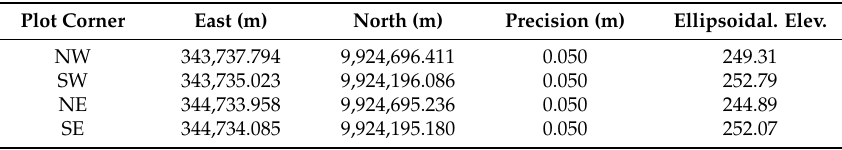
Table 2. Coordinates of the four corners of the plot (UTM 18S).